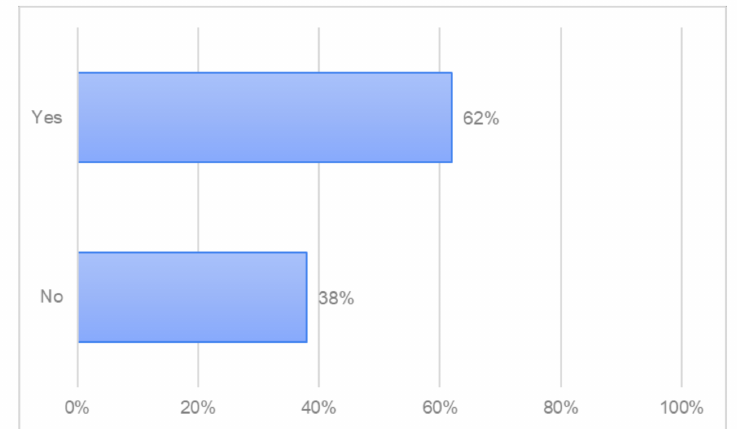
Figure 16. Tree climbers with/without the first aid kit at work on the